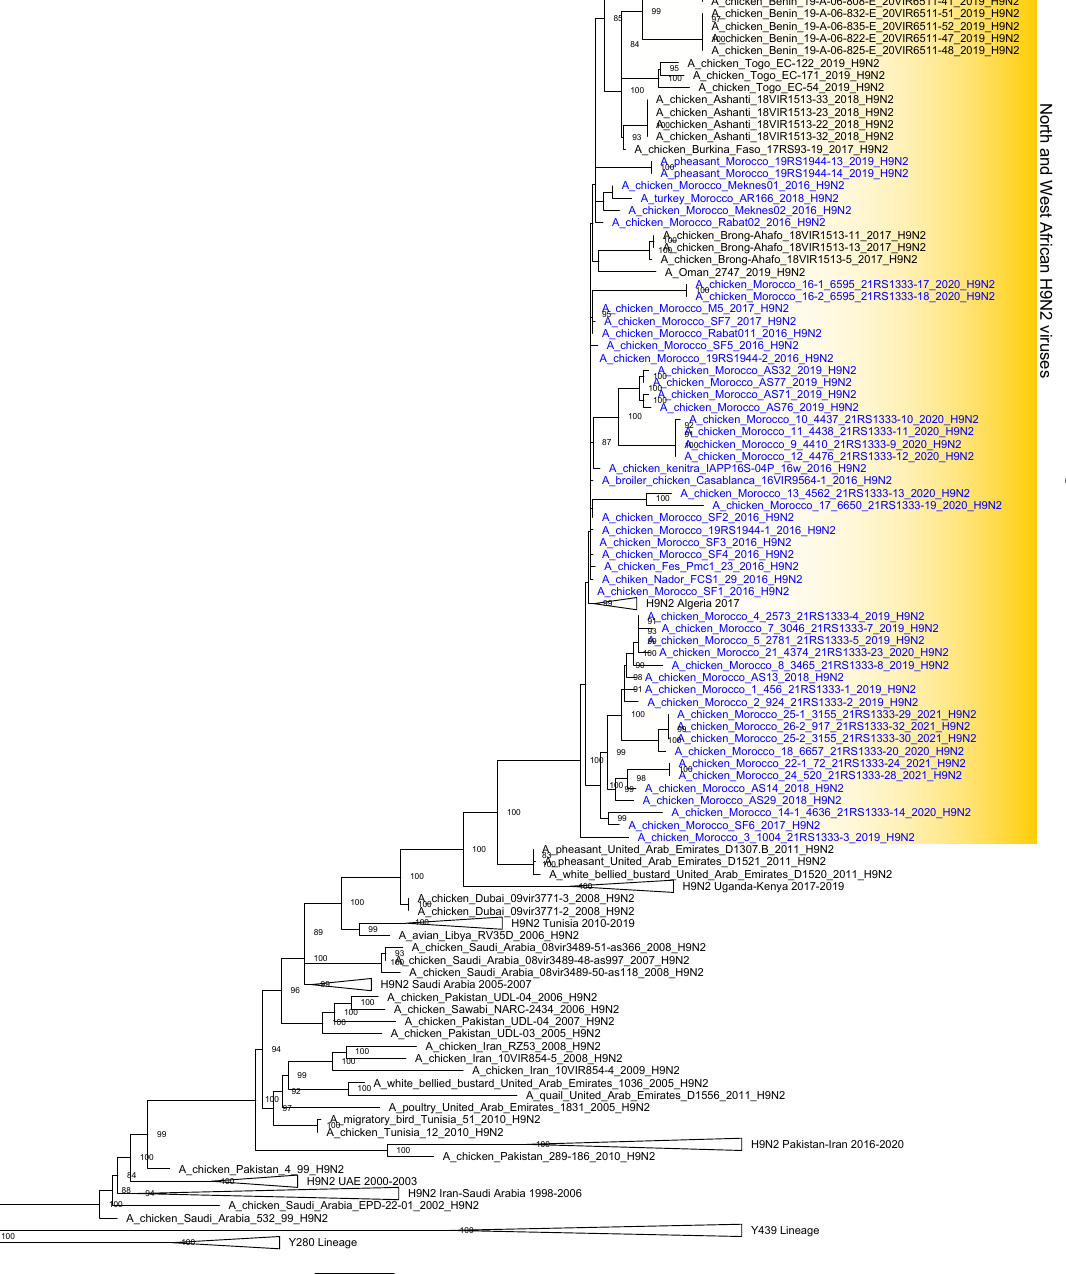
Figure 2. Maximum Likelihood phylogenetic tree of the HA gene (IQ-TREE v.1.6.8). The H9N2 viruses from Morocco analyzed in this study are marked in blue.Ultra-fast bootstrap supports equal to or higher than 80% are indicated next to the